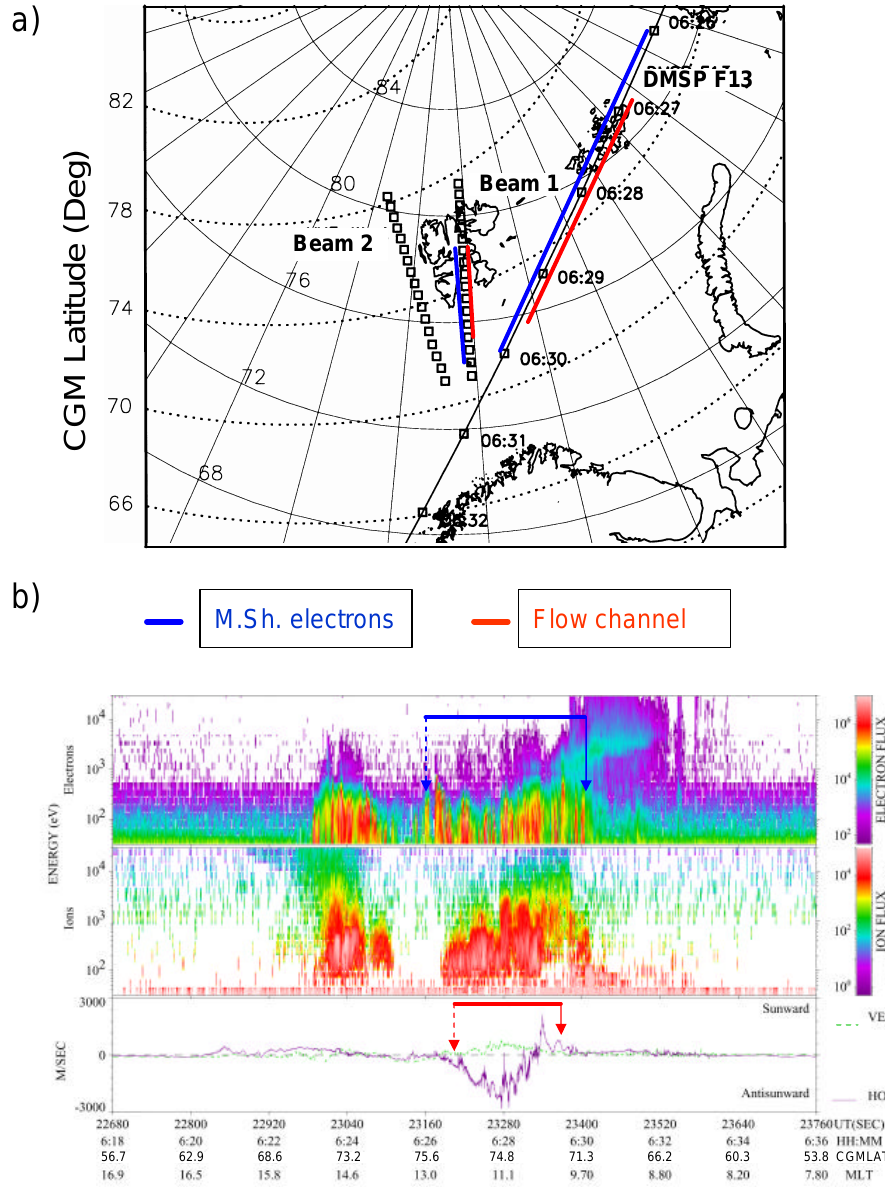
Fig. 3. (a) The geometry of the DMSP F13 pass east of EISCAT’s Beam 1 and Beam 2 around 06:30UT. The blue bar along the satellite trajectory marks the spatial extent of magnetosheath electron precipitation, and the red bar marks the extent of a convection flow channel observed by the satellite. These bars have been mapped along the L-shells onto Beam 1 and will be compared with electron and ion gas temperatures measured by EISCAT. (b) Electron and ion precipitation fluxes and cross-track (magenta) and vertical (green) flows measured by the drift meter on board DMSP. The blue bar corresponds to the blue bars in (a), and the solid arrow (dashed arrow) marks the equatorward (poleward) edge of intense magnetsheath-like electron precipitation. The red bar and arrows mark out the convection channel to be compared with enhanced EISCAT T i